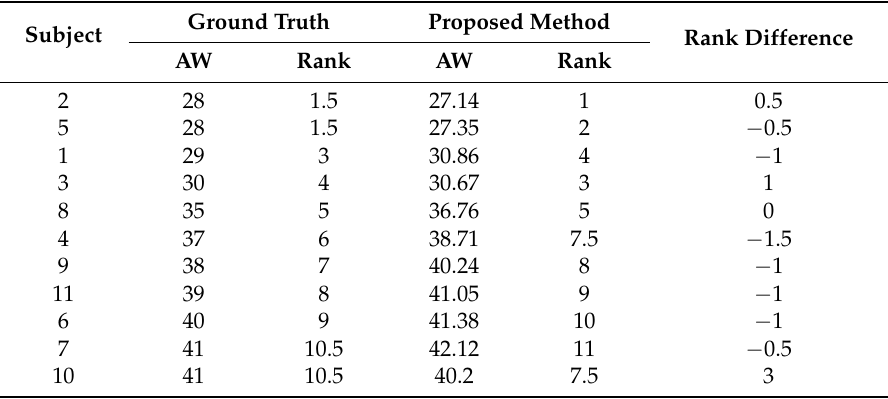
Table 3. Individual subject rankings based on